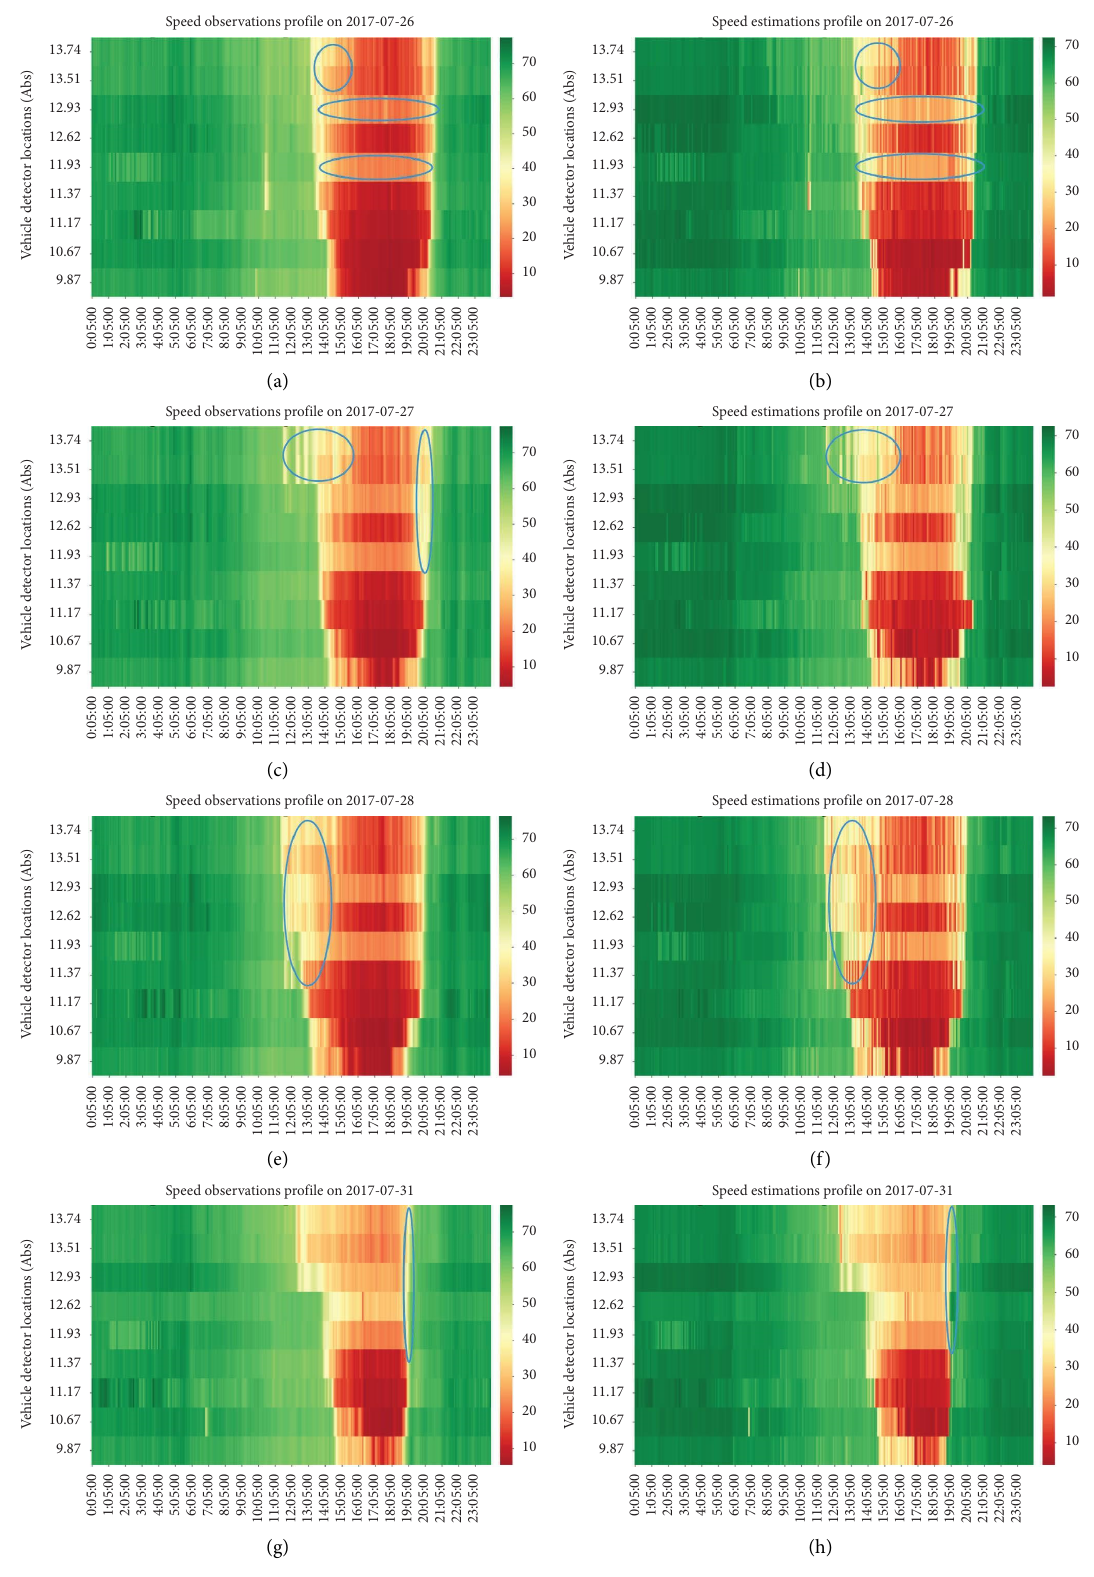
Figure 9: Comparison speed between observations and estimations on diferent days. (a) Speed observations on 07/26/2017, (b) Speed estimations on 07/26/2017, (c) Speed observations on 07/27/2017, (d) Speed estimations on 07/27/2017, (e) Speed observations on 07/28/ 2017, (f) Speed estimations on 07/28/2017, (g) Speed observations on 07/31/2017, and (h) Speed estimations on